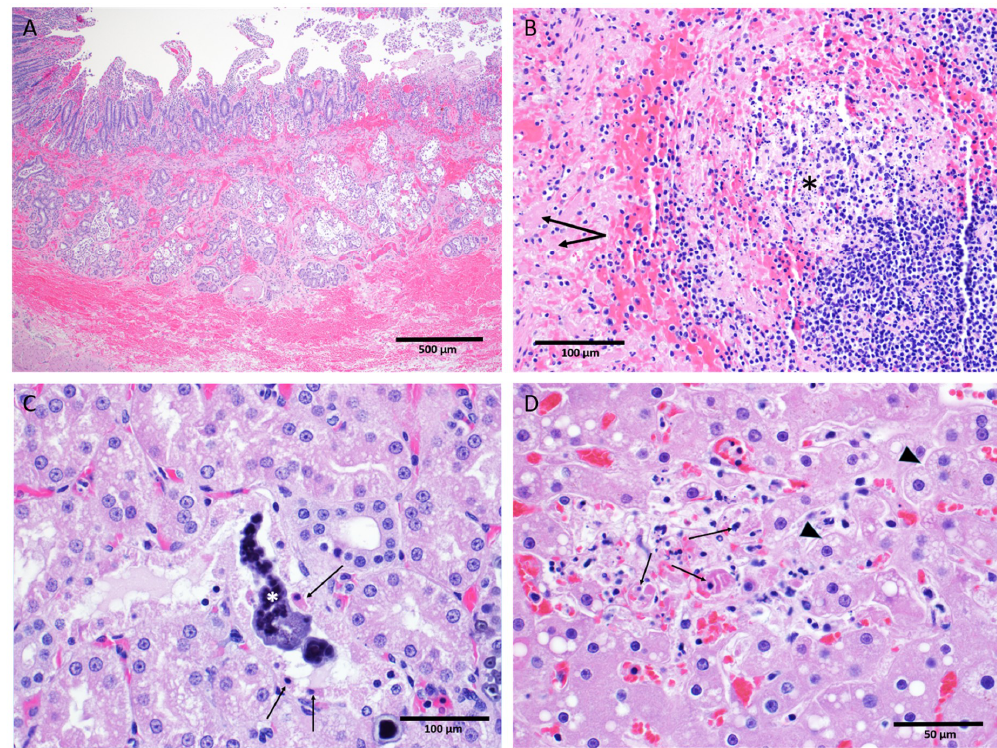
Figure 10. Salient microscopic findings in rhesus macaques exposed to IM EBOV. ( A ) Small intestine, duodenum: Di ff use hemorrhage expanding the mucosa and submucosa. ( B ) Spleen, white pulp: Lymphocyte depletion with lymphocytolysis (asterisk) and fibrin deposition (arrow) in the adjacent red pulp; ( C ) Kidney tubules: Necrosis of the tubular epithelium (arrows) with intratubular mineralization (asterisk). ( D ) Liver: An area containing hepatocellular degeneration (arrow heads) and necrosis